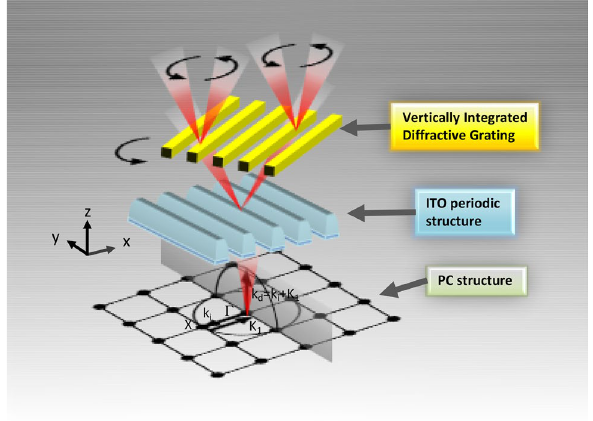
Figure 2. Illustration of the operation principle of VIDG-PCSEL is shown. The laser beam (in red color) emitted from the PC structure is split into two by the periodic structure of ITO layer and then deflected by the diffractive element made of metal grating.